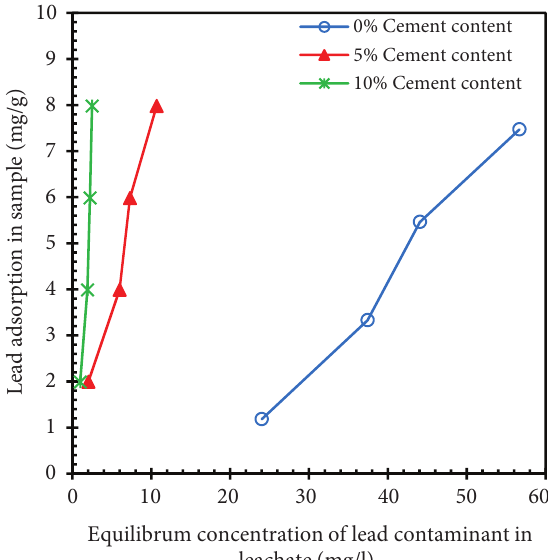
Figure 7. Adsorption isotherms for lead ions